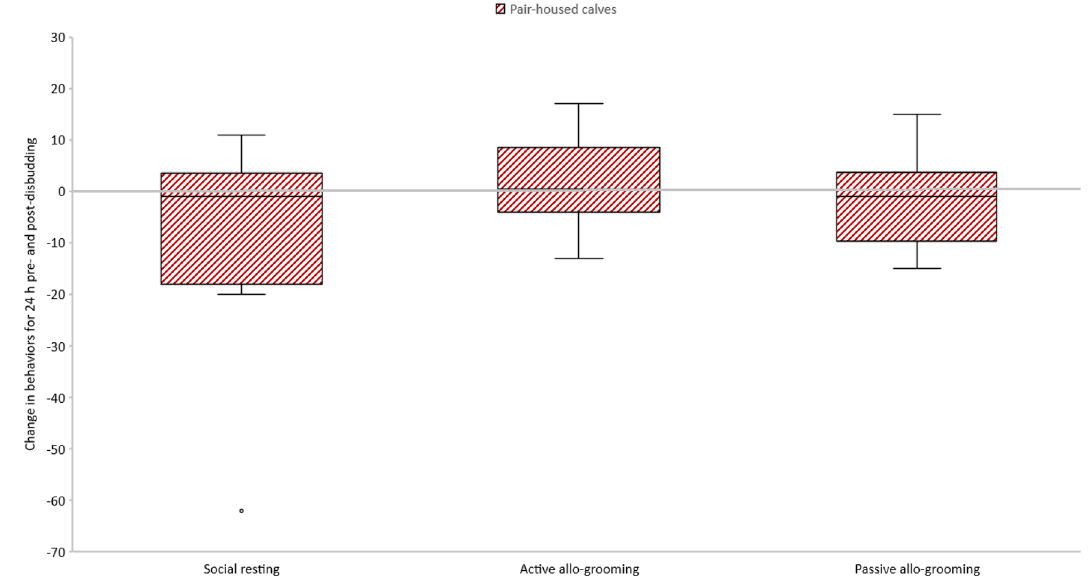
Figure 2. Changes in social behaviors in pair-housed calves (n = 12) calculated as difference between post-and pre-disbudding behavior. The boxplots depict median, interquartile range, data range as whiskers and outliers as